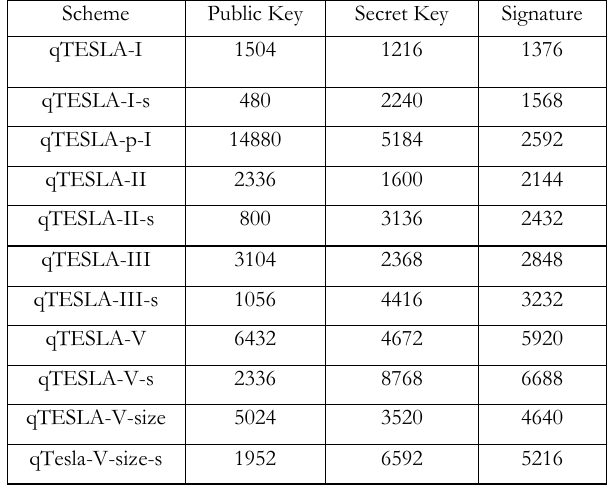
Table 9: Second Round Reference Implementation Key Sizes in